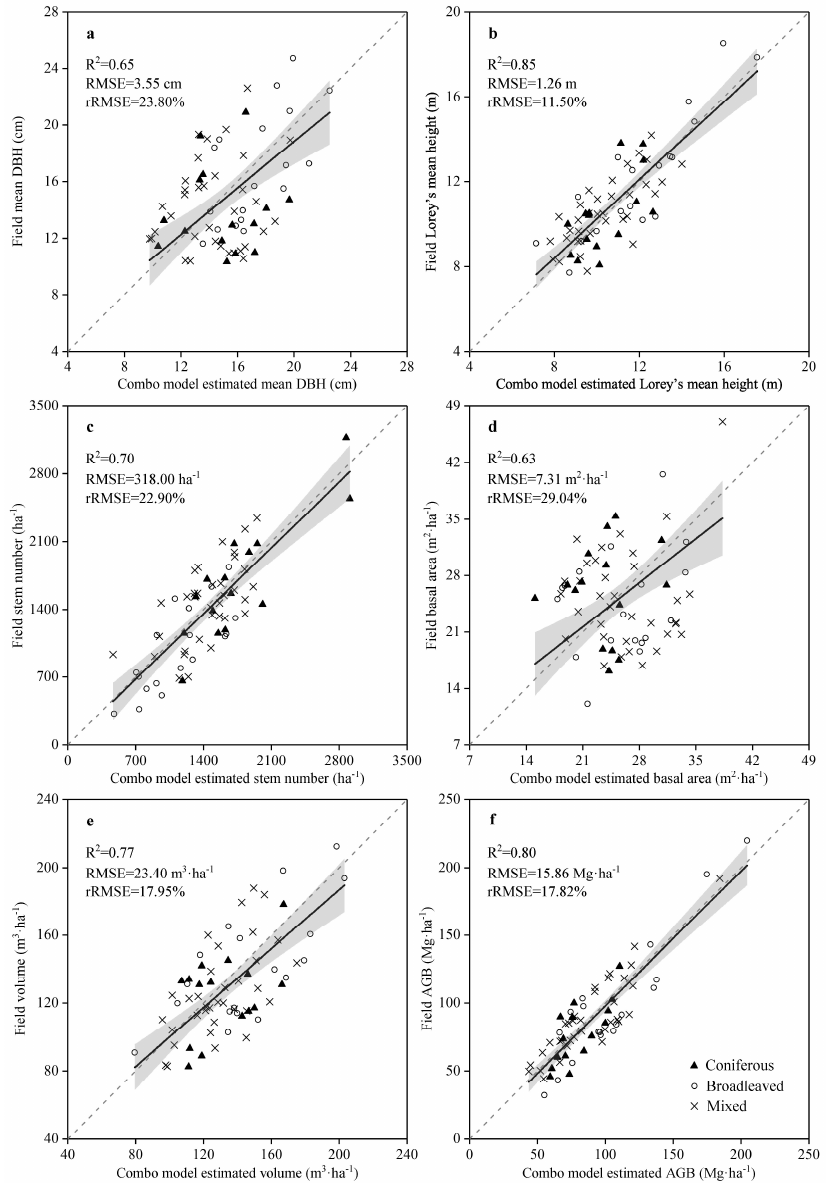
Figure 7. Scatterplots of forest structural parameters between the field surveyed and combo model predicted in cross validation, i.e., forest structural parameters: ( a ) DBH; ( b ) H L ; ( c ) N; ( d ) G; ( e ) V; and ( f ) AGB.